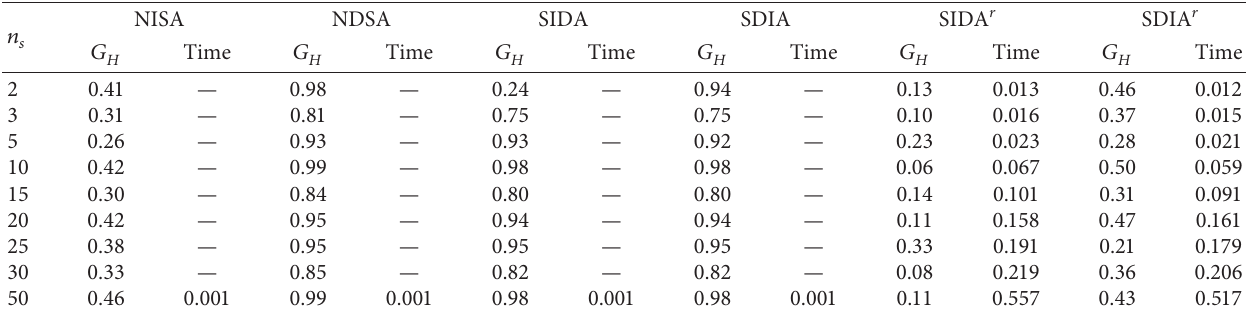
Table 9: The behavior of G H and time when the number of storage supports is